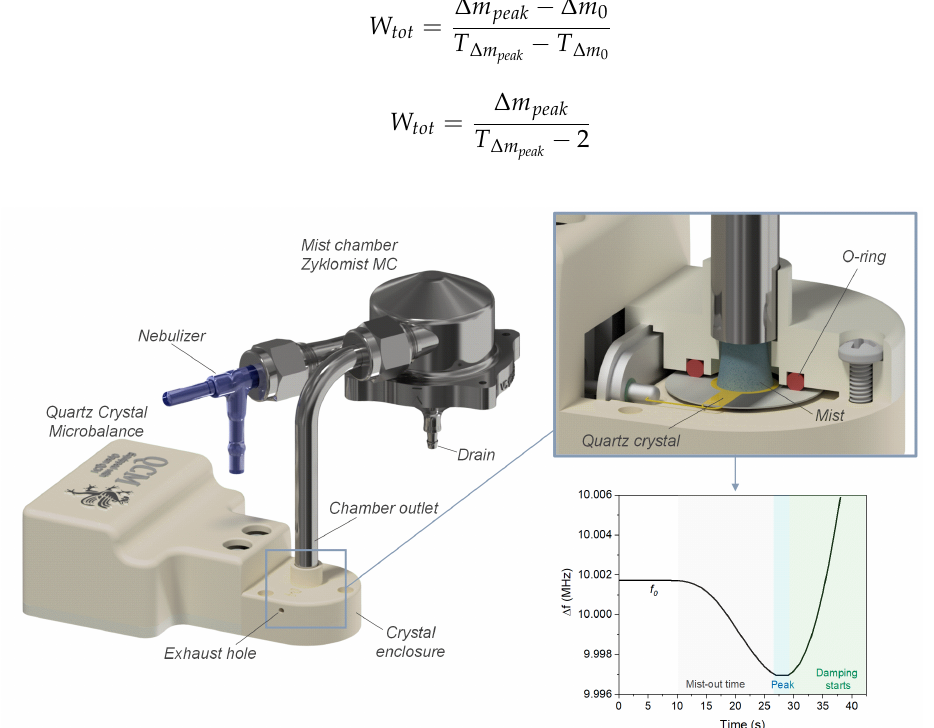
Figure 3. QCM setup for mist-out time and misted mass transport rate measurements, obtained from the given “ ∆ f vs. time” curve. Note that the mist chamber outlet is enclosed to avoid air flow that could disturb the measurement and to contain the mist within the sampling area; yet, two symmetrical exhaust holes (Ø = 1 mm) were included to avoid overpressure and fast accumulation of the